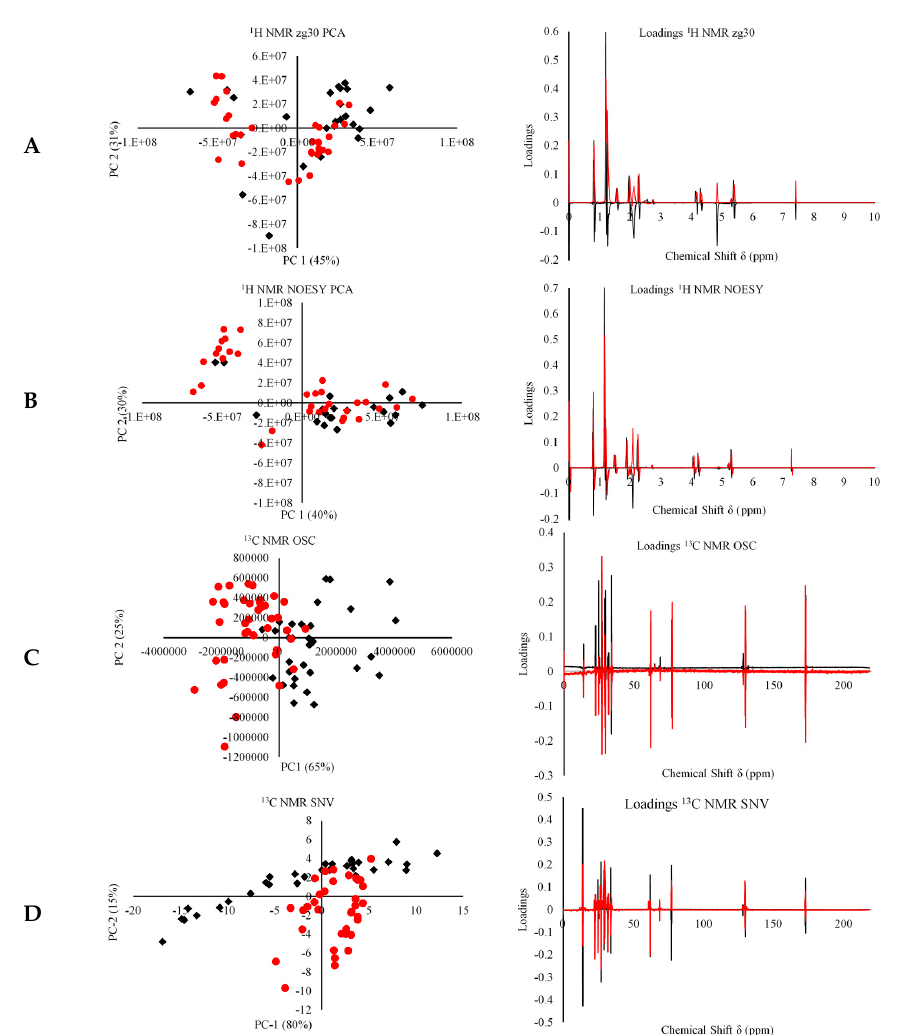
Figure 3. The principle component analysis (PCA) biplots (black boxes = Maltese red dots = non-Maltese) and loading plots for PC1 (black line) and PC2 (red line) for the untreated raw data for the zg30 ( A ) NOESY ( B ), 13 C NMR orthogonal scatter corrections (OSC) ( C ), and 13 C NMR standard normal variate (SNV) ( D ) spectra.